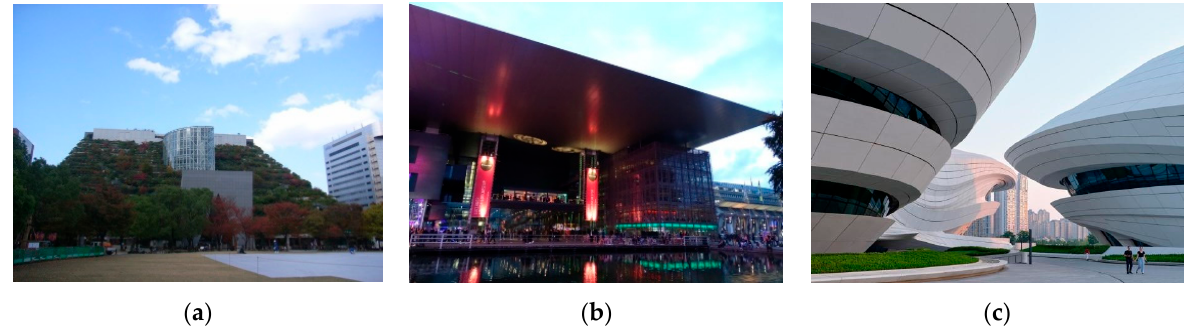
Figure 20. Views of investigated buildings: ( a ) Prefectural International Hall “Asian Cross Road Over the Sea”, photograph by B. Majerska-Pałubicka; ( b ) Kultur- und Kongresszentrum Luzern, photograph by B. Majerska-Pałubicka and ( c ) Changsha Meixihu International Contemporary Art Museum, the photograph sourced from the official website of zaha-hadid.com [34].